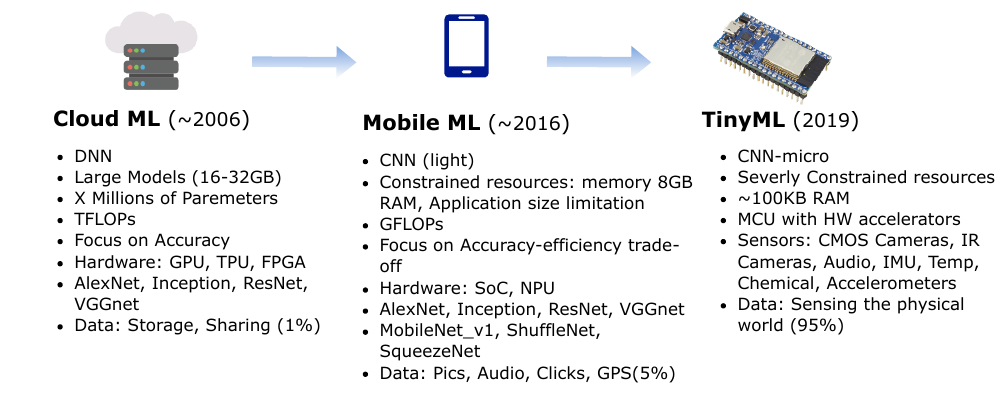
Figure 1. The advancement of computing technology over time.